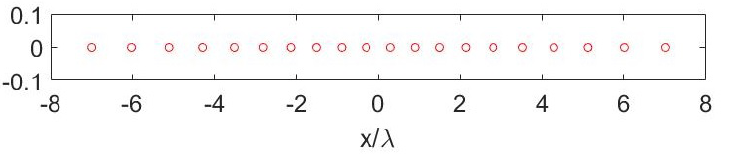
Figure 9. Optimized Gaussian quadrature points for the case a T = 5 λ , a R = 7 λ , d = 7 λ and N = 20.